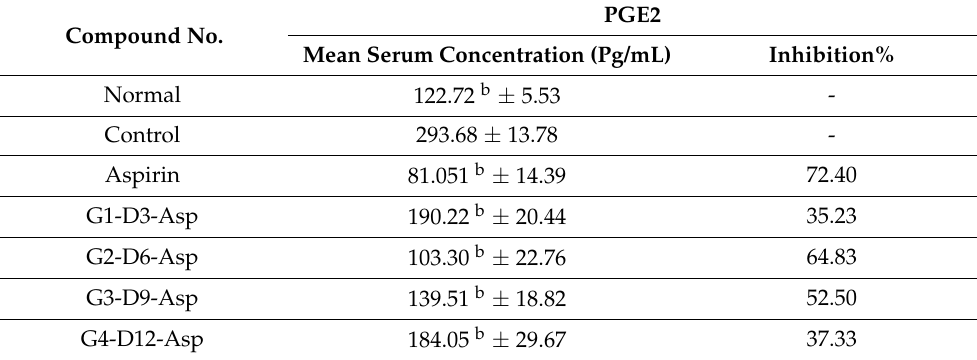
Table 5. In vivo study of rat serum PGE2.